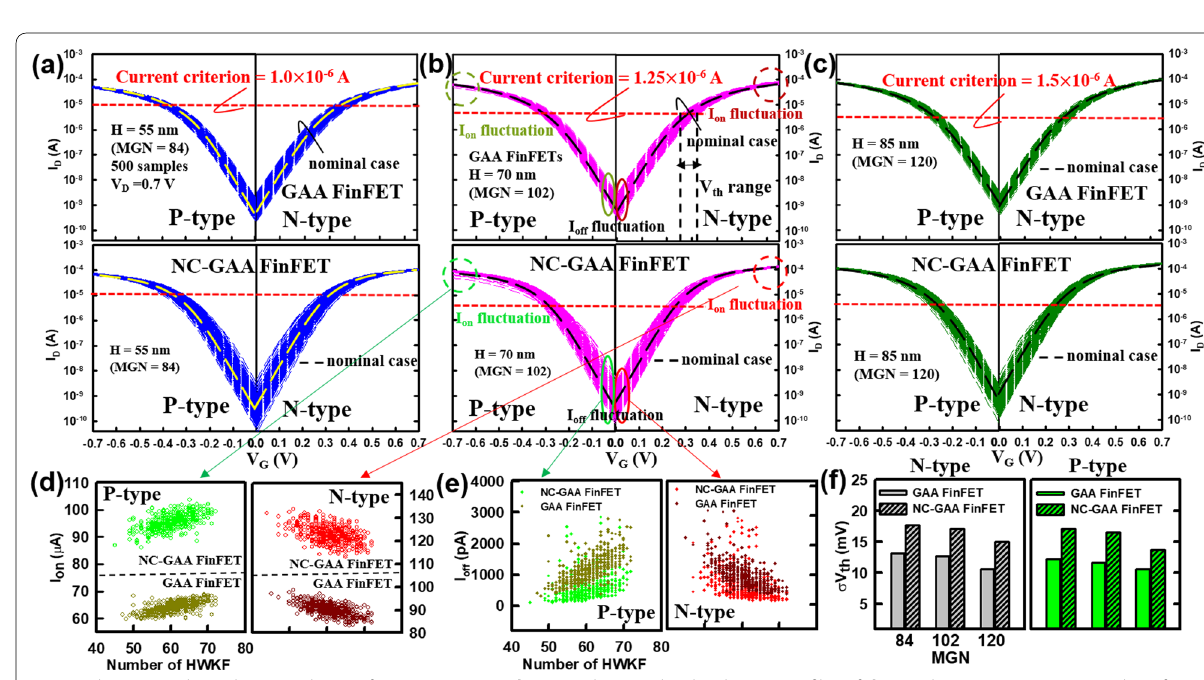
Fig. 8 The WKF with random 500 devices for MGNs are a 84, b 102 and c 120. The distribution profiles of d I on and e I off versus HWKF numbers for N‑/P‑type GAA and NC‑GAA FinFETs with the fixed MGN. f The comparison of σV th versus the different MGNs. It can be observed that the σV th of GAA FinFETs is smaller than that of NC‑GAA FinFETs. It implies that NC‑GAA FinFETs perform more sensitively induced by the